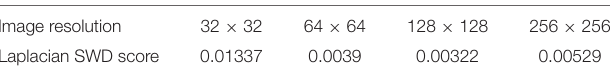
TABLE 2 | The Laplacian SWD values for increasing resolutions.